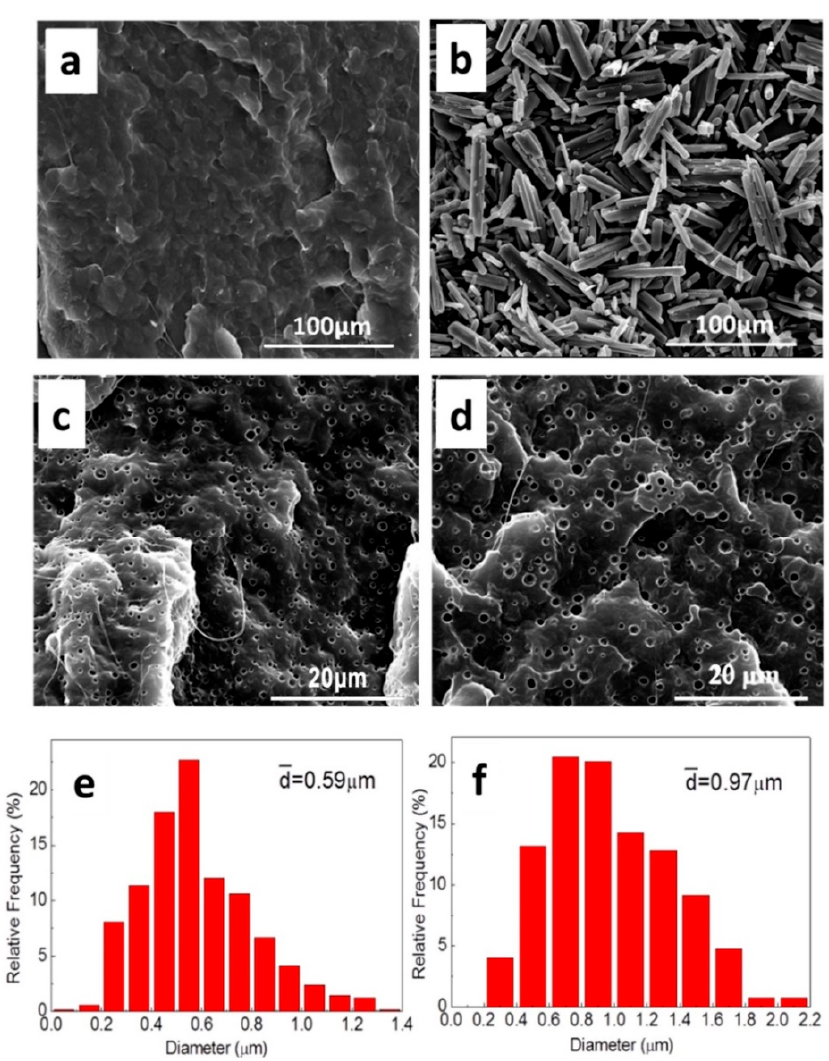
Figure 3. SEM images of ( a ) PCL, ( b ) MPT, and PCL/MPT after immersed in PBS for 72 h: ( c ) MPT5- 100 and ( d ) MPT5-130; MPT pore size distribution: ( e ) MPT5-100 and ( f ) MPT5-130.